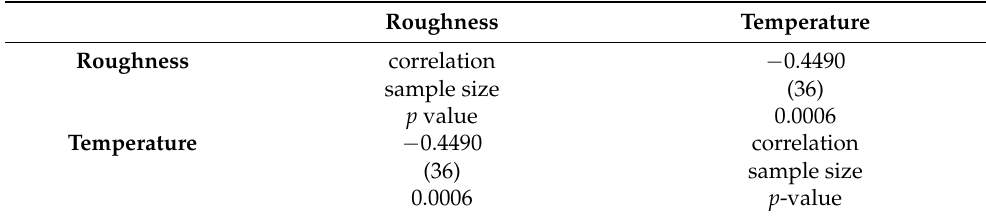
Table 7. Correlation matrix between the cutting temperature and surface roughness. The number of pairs of data values used to compute each coefficient are in parentheses.